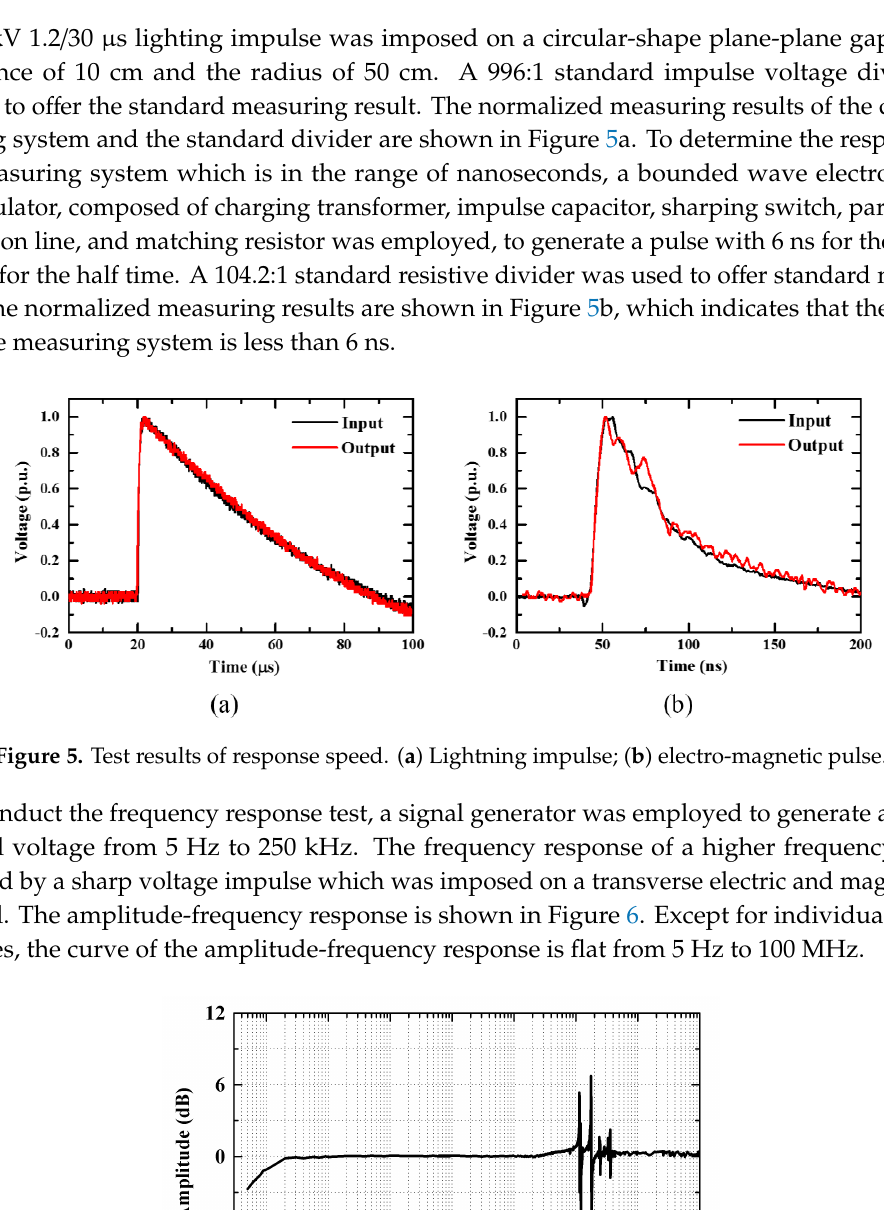
Figure 6. Amplitude-frequency response.